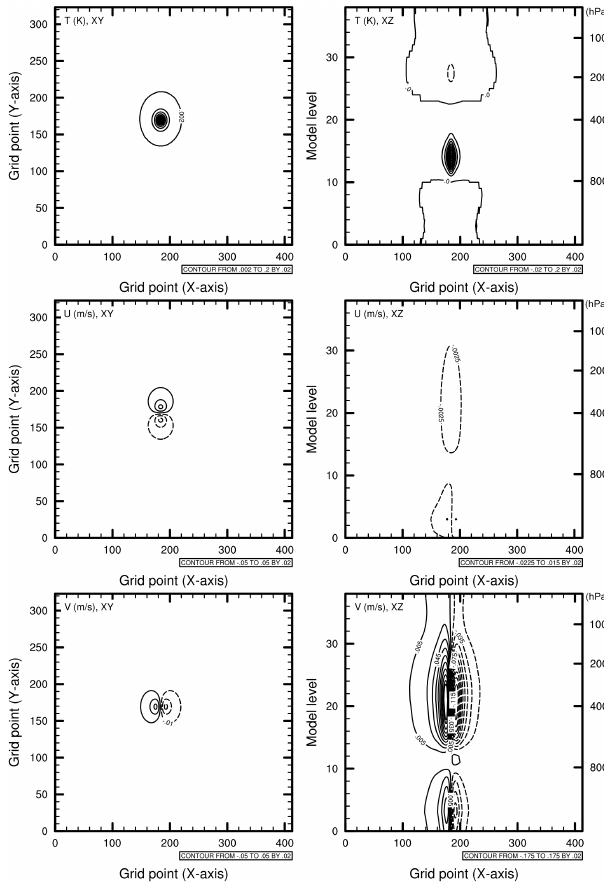
Figure 11. Pseudo observation test of temperature (innovation of + 1K) from the WRFDA application. The three plots in the left panel show, from top to bottom, horizontal cross sections ( XY ) of the t (K), U and V wind components (ms − 1 ) , respectively. Then, the right panel shows the corresponding cross section ( XZ ) of the